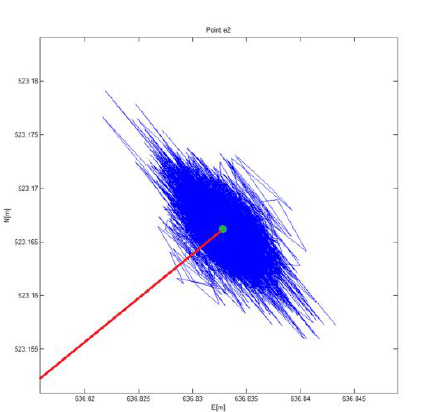
Figure 17. Raw and corrected values of height for point f9 (with reference to the station)